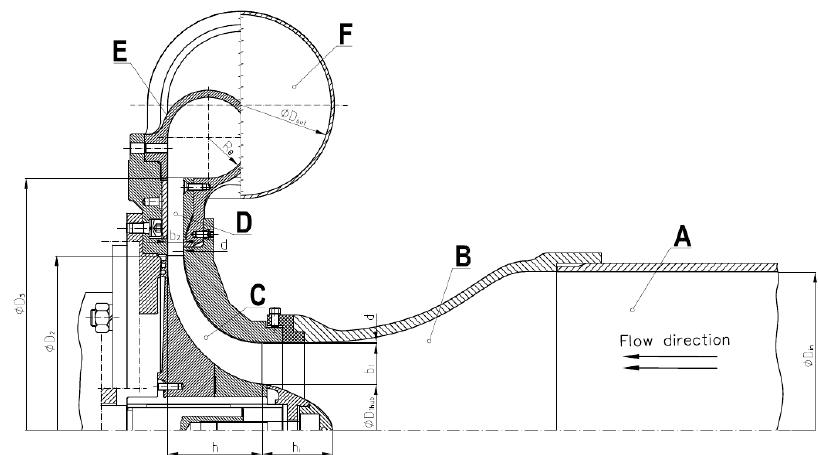
Figure 1: Cross-section of the DP1.12 blower used in this study with the most important